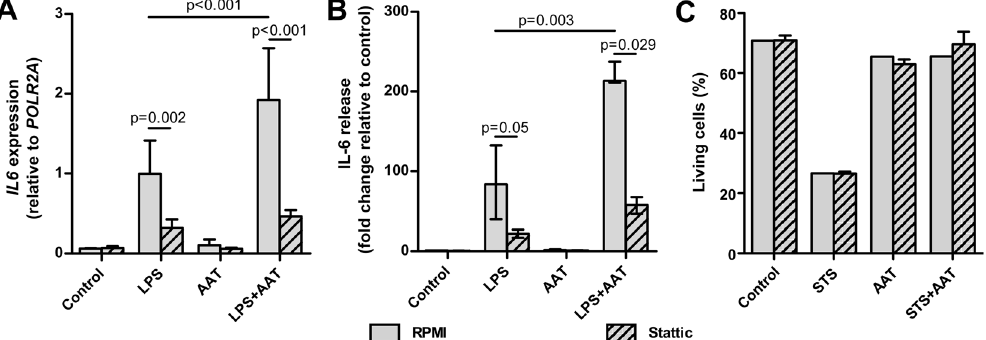
Figure 12. Effects of stattic (STAT3 inhibitor) on LPS-induced IL-6 production and STS-induced apoptosis in H1975. Cells were treated with 5 µ M stattic for one hour prior to addition of HBSS (control), 10 µ g/ml LPS,